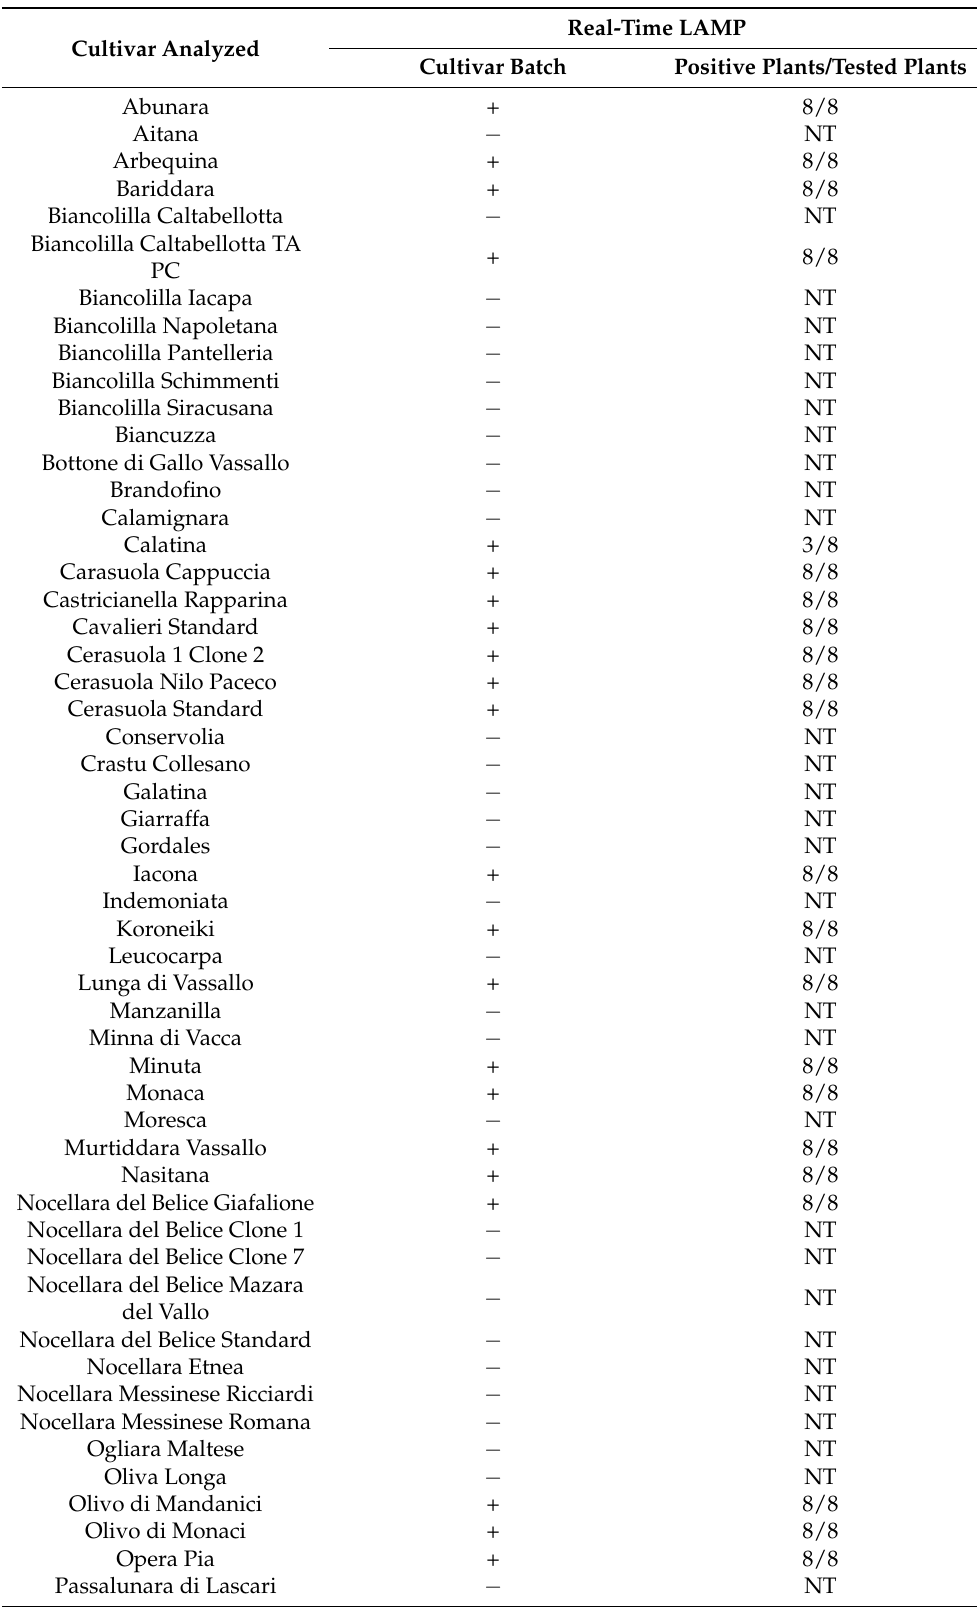
Table 6. Incidence of OEGV evaluated using a real-time LAMP assay on samples prepared with the “membrane spot crude extract”